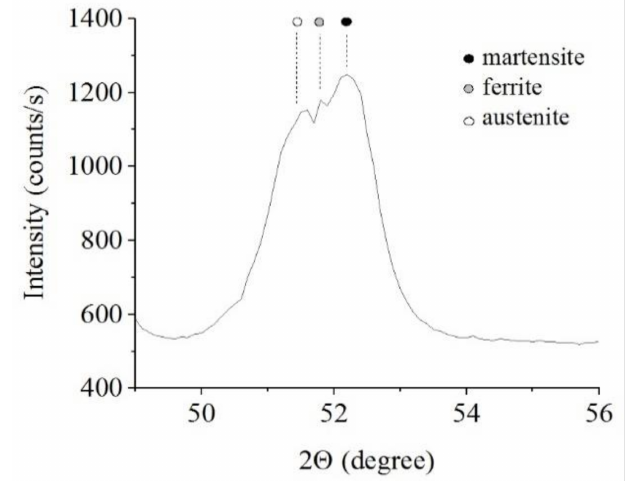
Figure 3. X-ray diffraction patterns of the steel surface layer after